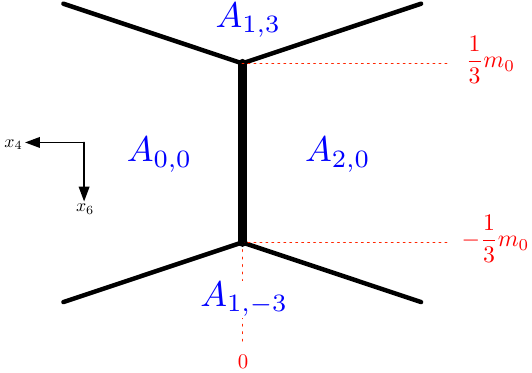
indicates the largest A ( m ) in the region. The black solid lines are k;l k;l